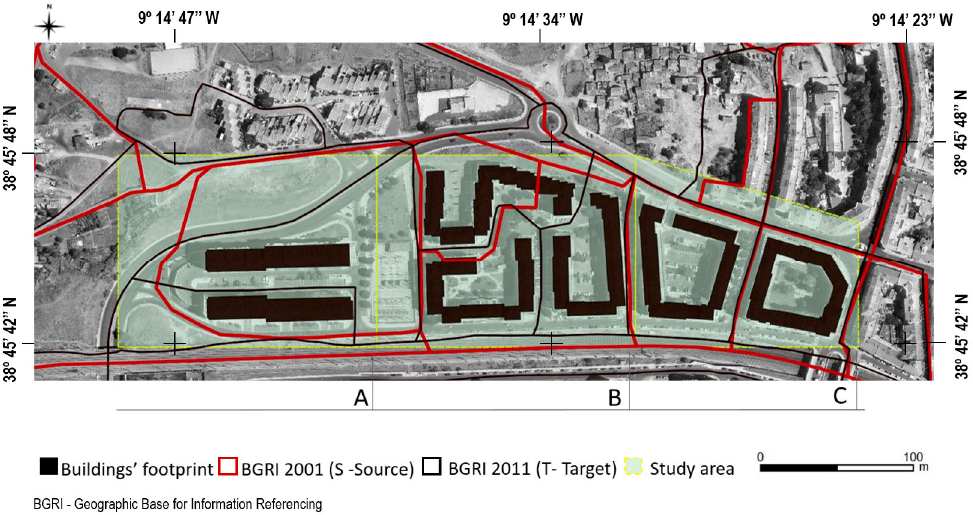
Figure 1. Study area with census tracts and building footprints.